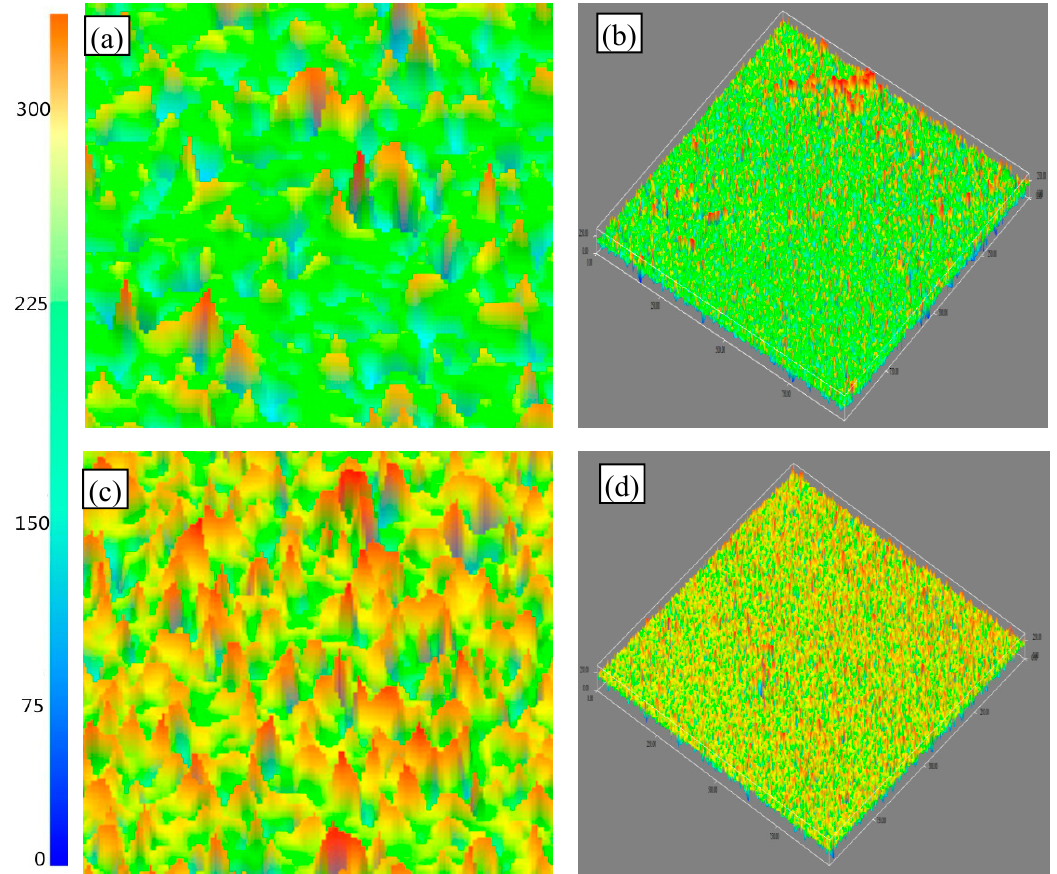
Figure 8. Morphology of plain steel fiber and zinc phosphate modified steel fiber: ( a ) 2D morphology of plain steel fiber, ( b ) 3D morphology of plain steel fiber, ( c ) 2D morphology of phosphatized steel fiber, and ( d ) 3D morphology of zinc phosphate modified steel fiber.